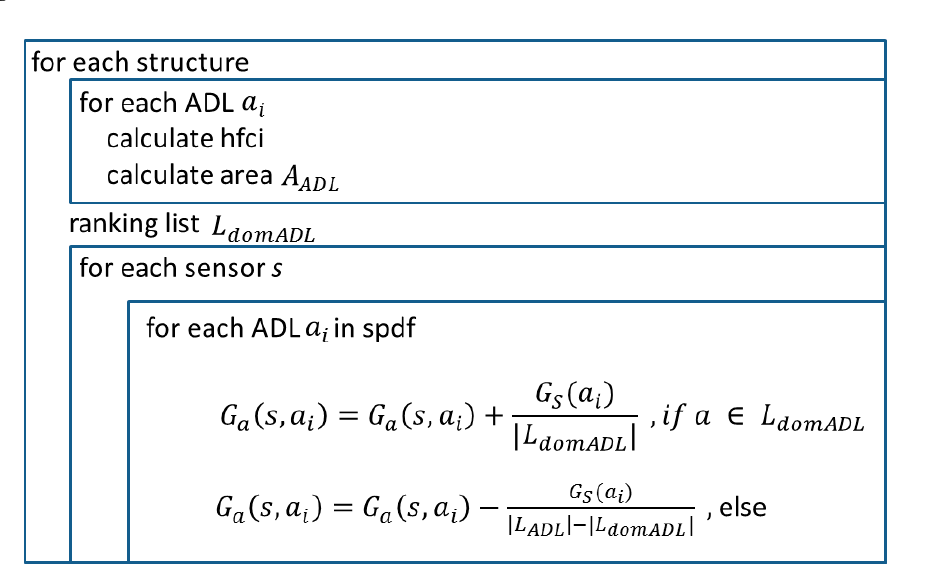
Figure 4. Algorithm for the spdf calculation. It shows one iteration, which is repeated until no changes occur